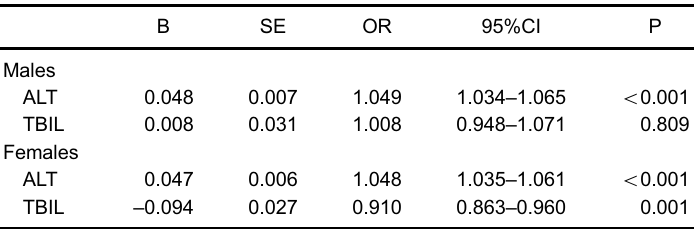
Table 4. Binary logistic regression of risk for metabolic